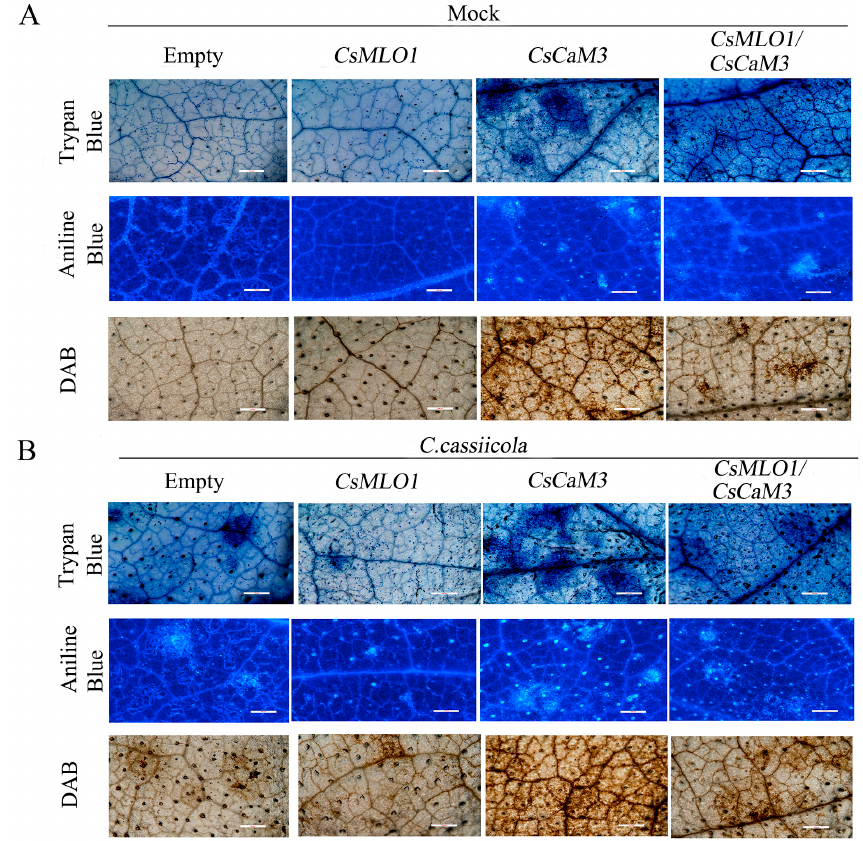
Figure 8. Effects of agroexpression of CsCaM3 and CsMLO1 on cell death and defense responses of cucumber leaves. ( A ) Trypan blue, aniline blue, and DAB staining of cucumber cotyledons 5 d after agroexpression with the indicated transgenes. ( B ) Trypan blue, aniline blue, and DAB staining of cucumber cotyledons 3 d after C. cassiicola challenge with transgenes. Bars = 500 μ m. Transcription level measurements supported significantly attenuated or strengthened cell death and H 2 O 2 burst in CsMLO1 - or CsCaM3 -overexpressing cucumber cotyledons, respectively (Figure 9; Figure 10). CsCaM3 overexpression strongly induced H 2 O 2 signaling-related genes, including ascorbate peroxidase ( CsPO1 ) and NADPH oxidase homolog ( CsRbohD and CsRbohF ), including defense-related genes ( CsPR1 and CsPR3 ) and callose deposition-related gene ( CsGSL ). However, these related genes were not induced in CsMLO1 -overexpressing cells (Figure 9). Notably, the extent of the increase in the transcription levels of these genes was significantly inhibited after coexpression of CsMLO1 and CsCaM3. To examine whether the transcription level of related defense genes in transgenic cucumbers was changed under the stress of C. cassiicola , we also detected the expression of the above related genes (Figure 10). The data showed that changes in the expression of these genes